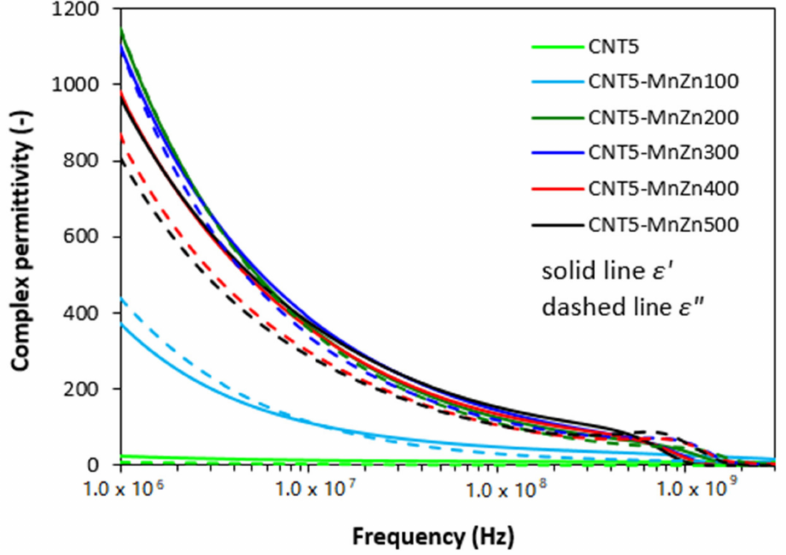
Figure 8. Frequency dependences of real ε′ and imaginary ε″ parts of complex permittivity for hybrid CNT/ferrite filled composites.